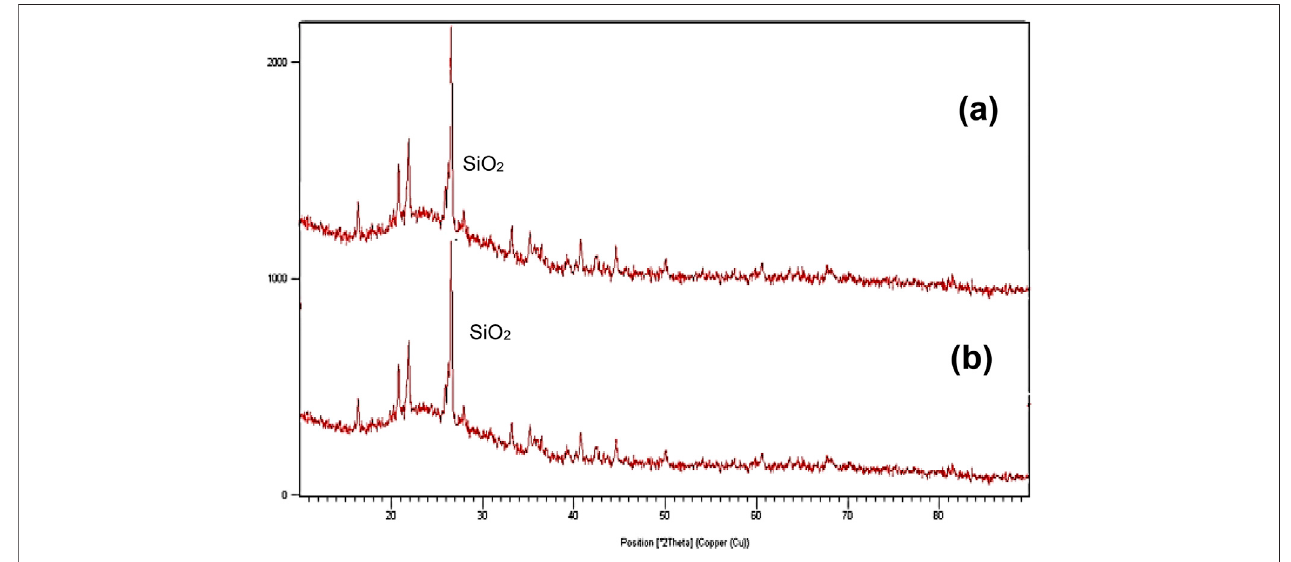
FIGURE 1 | XRD analysis for (A) 45 and (B) 75 µm of